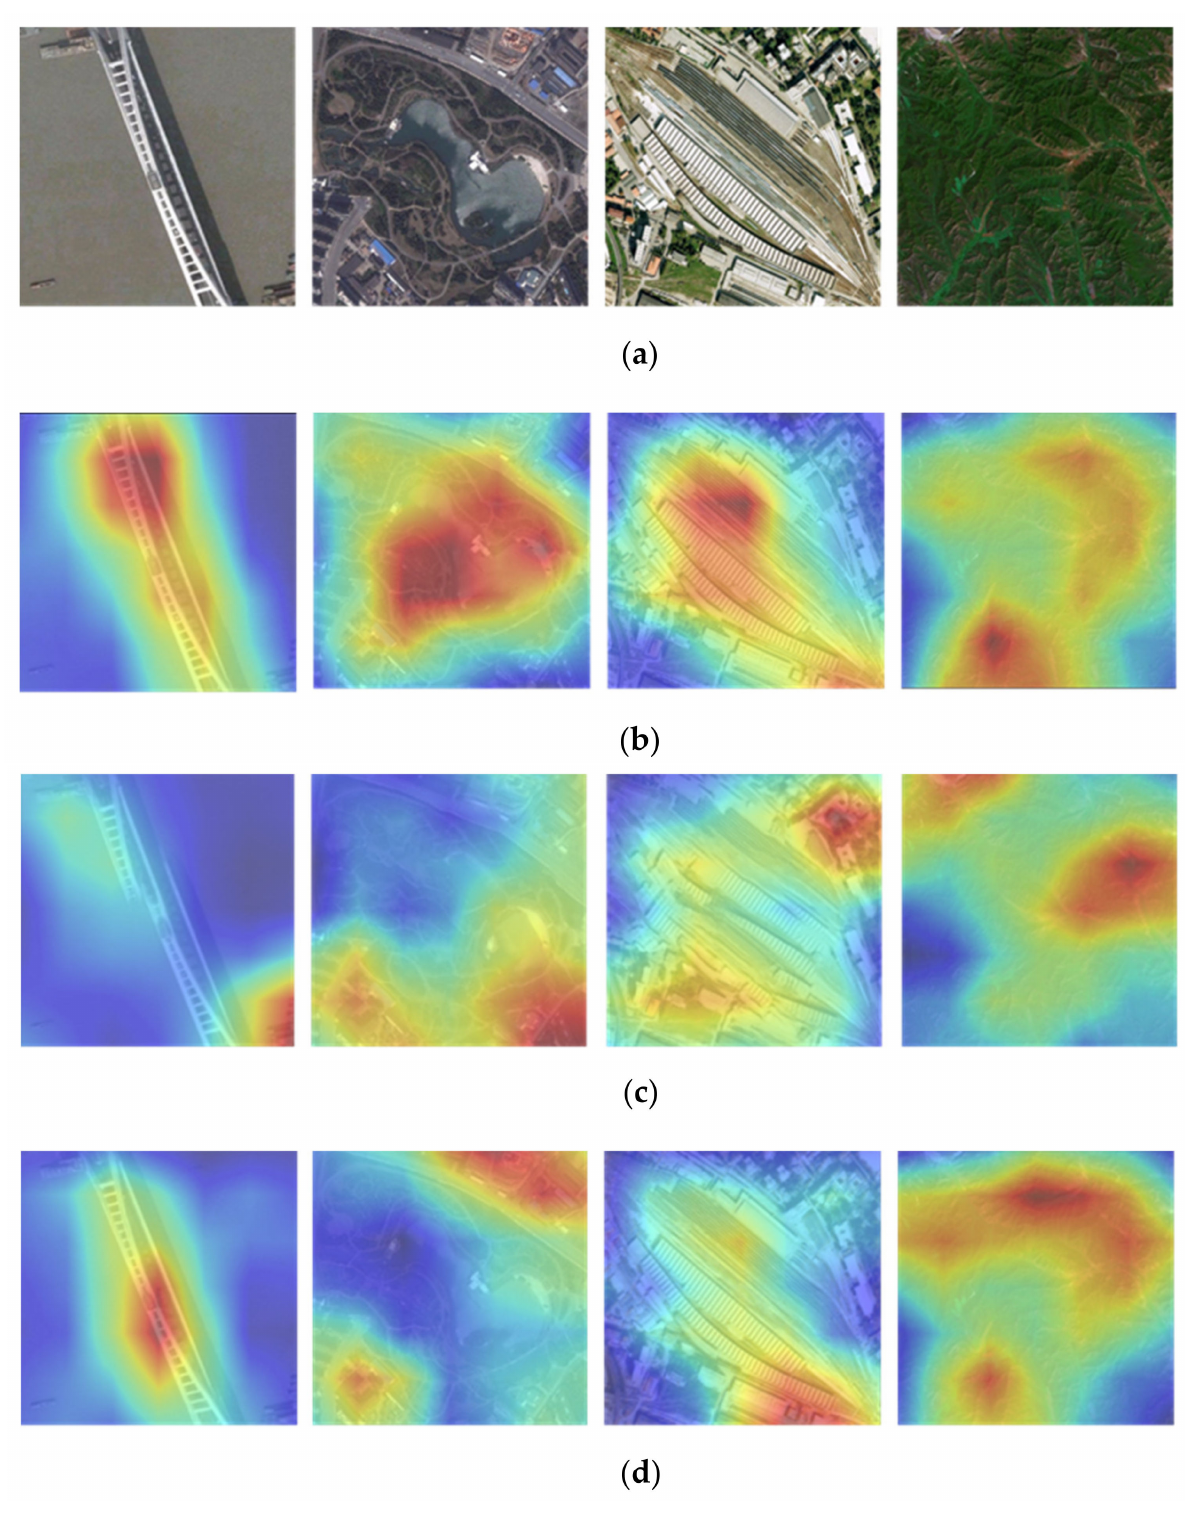
Figure 16. Original remote sensing images and the attention maps derived from the VGG16 network. ( a ) Original remote sensing images. ( b ) Visualization results of the original images. ( c ) Visualization results of the fake samples by the original SinGAN. ( d ) Visualization results of the fake samples by the improved